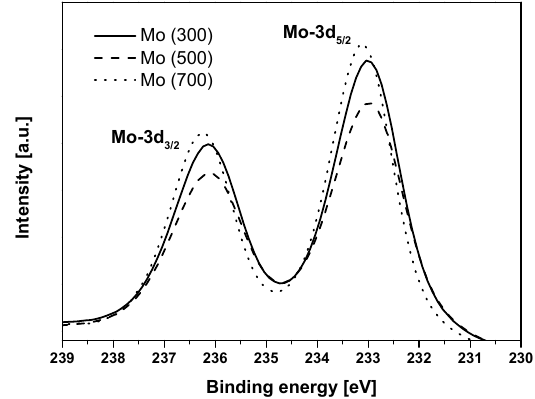
Figure 2. X-ray photoelectron spectra of the Mo 3d doublet corresponding to the bulk MoO 3 catalysts.